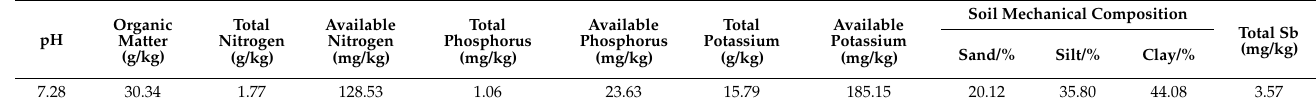
Table 1. Physicochemical characteristics of the natural field soil used in this